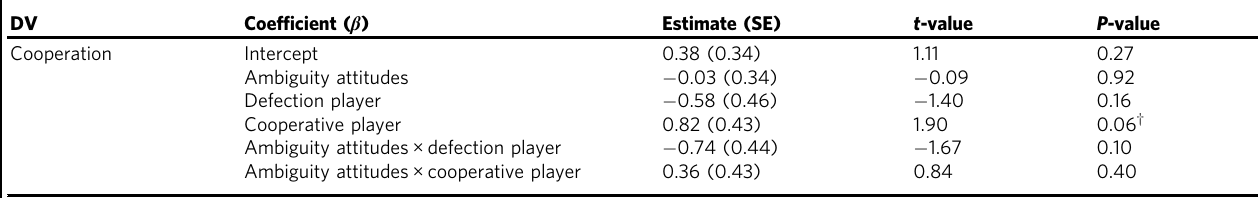
Table 5 Experiment 3: Ambiguity attitudes in the prisoner ’ s dilemma during sampling phase DV Coef fi cient ( β )